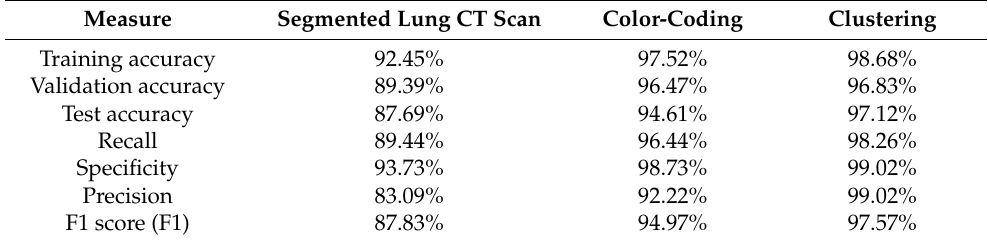
Table 7. Performance of proposed model on segmented CT scan dataset, color-coding-based approach, and clustering-based